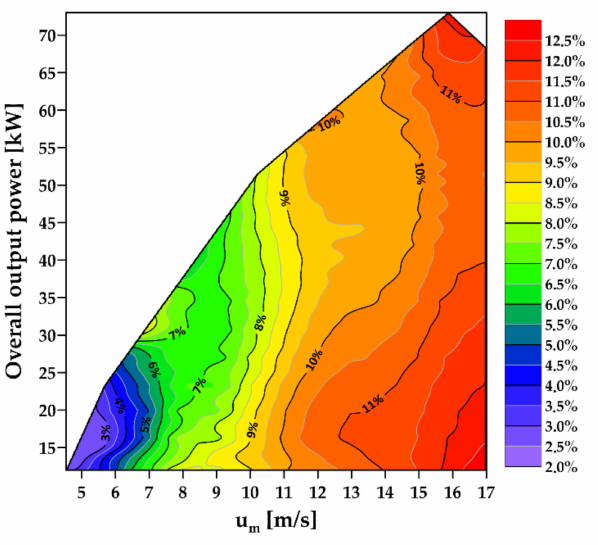
Figure 17. Efficiency improvement of the compound engine with respect to the reference tur- bocharged engine as a function of power output and mean piston speed for T 4 /T 1 = 3.5 and η T =